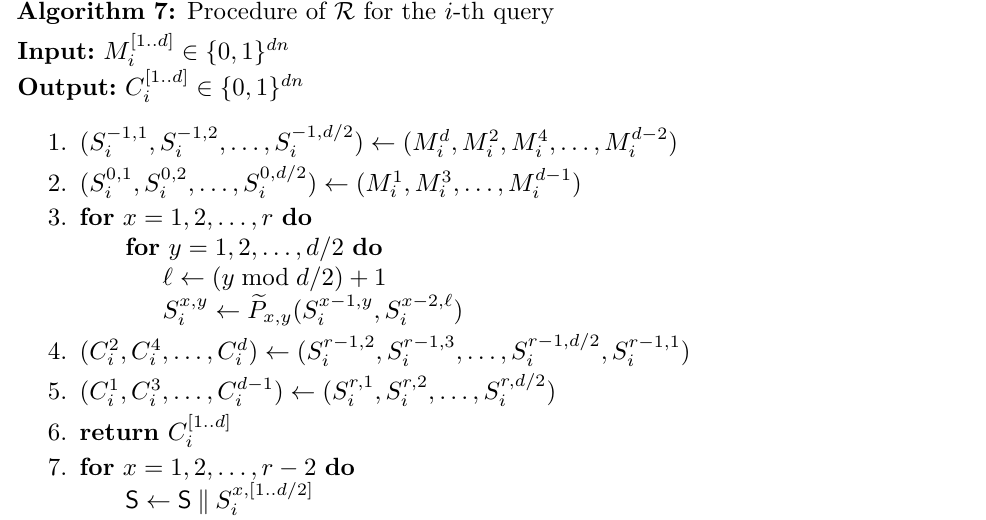
Algorithm 7: Procedure of R for the i -th query